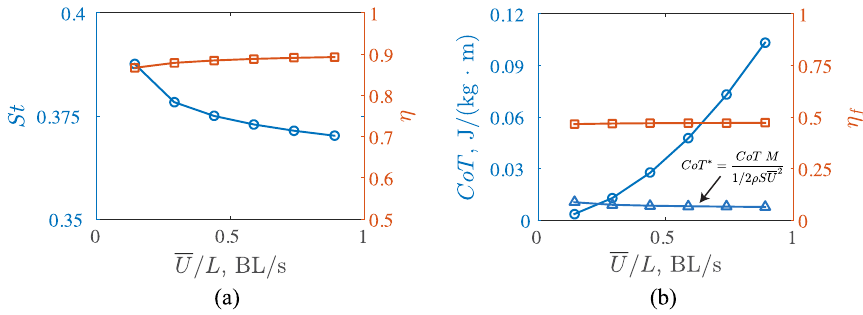
Figure 12. ( a ) St as a function of swimming speed per unit body length (left axis). The right axis shows the corresponding propulsive efficiency; ( b ) The left axis shows the cost of transport as a function of swimming speed per unit body length. A non-dimensional cost of transport CoT* is also plotted on the left axis. The right axis shows the Froude efficiency.